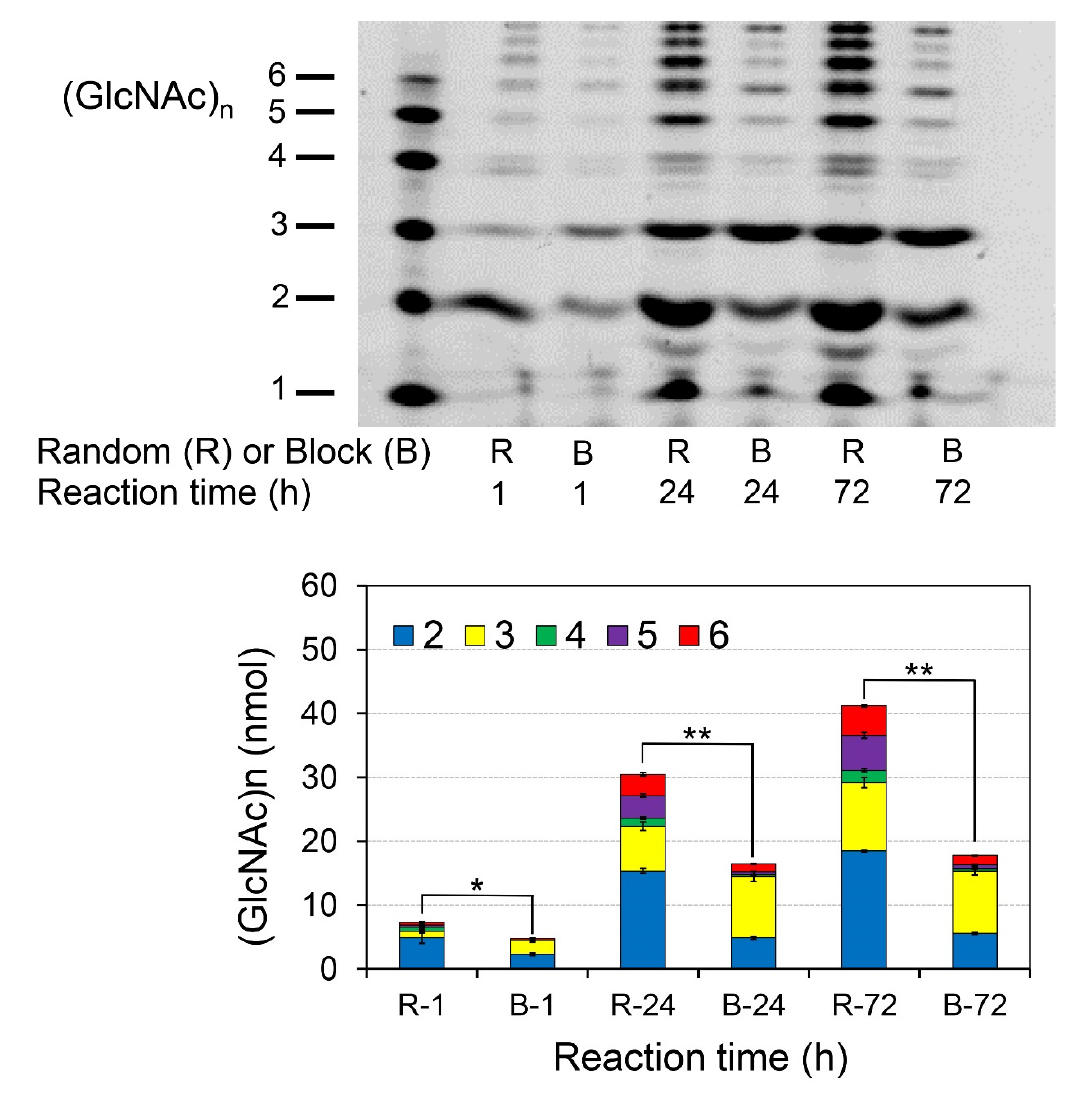
Figure 5. Chia produces chitooligosaccharides with more variable sizes from random-type chitosan when compared to the block-type form. Direct comparison of the degradation products from DD 69% block-type (B) and DD 45% random-type (R) chitosan substrates is essentially as described in Figures 3 and 4. * p < 0.05; ** p < 0.01.